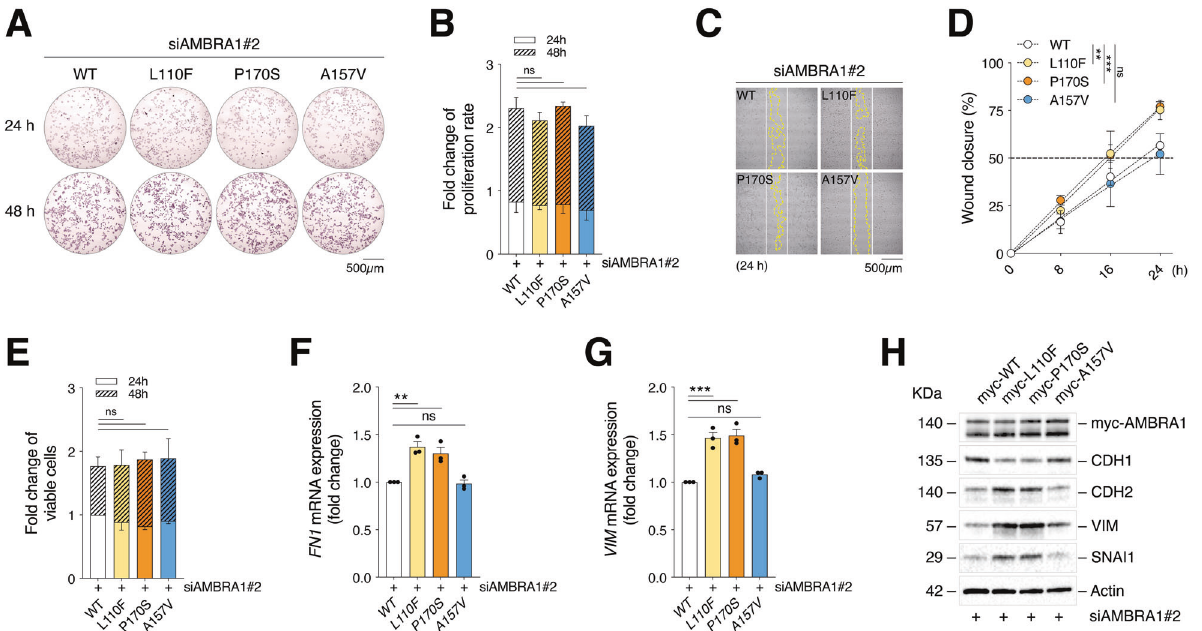
Fig. 5 Analysis of the effect of L110F and P170S mutants on melanoma invasiveness. A Representative Crystal Violet staining of WT-, L110F-, P170S- and A157V-expressing A375 cells after 24 and 48 h ( n = 3). B Quanti fi cation of the staining shown in ( A ). Data are shown as fold change ± SD with respect to control sample (WT at 24 h) ( n = 3; ns = not signi fi cant; two-way ANOVA). C Representative images ( n = 3) of wound healing assay in mutant-expressing A375 cells at 24 h. White and yellow lines outline wound edge at T 0 and at the time indicated. D Quanti fi cation of wound closure is shown as percentage ± SD vs T 0 at the times indicated ( n = 3; ns = not signi fi cant; ** p = 0.0018; *** p = 0.0004; two-way ANOVA). E Cell viability of WT-, L110F-, P170S- and A157V-expressing A375 cells after 24 and 48 h is expressed as fold change ± SD with respect to control sample (WT at 24 h) ( n = 3; ns = not signi fi cant; two-way ANOVA). F RT-qPCR analyses of EMT markers FN1 ( n = 3; ns = not signi fi cant; ** p = 0.0016 L110F vs WT; ** p = 0.006 P170S vs WT; one-way ANOVA) and G VIM ( n = 3; ns not signi fi cant; *** p = 0.0003 L110F vs WT; *** p = 0.0002 P170S vs WT; one-way ANOVA) upon WT, L110F, P170S and A157V re-expression. Data are expressed as fold change vs WT ± SEM. H A375 cells were re-expressed with AMBRA1-myc-tagged WT, L110F, P170S and A157V constructs and CDH1, CDH2, VIM and SNAI1 detected by WB. AMBRA1 was detected using an anti-myc antibody as transfection control whereas Actin as loading control. Images are representative of n = 3 independent